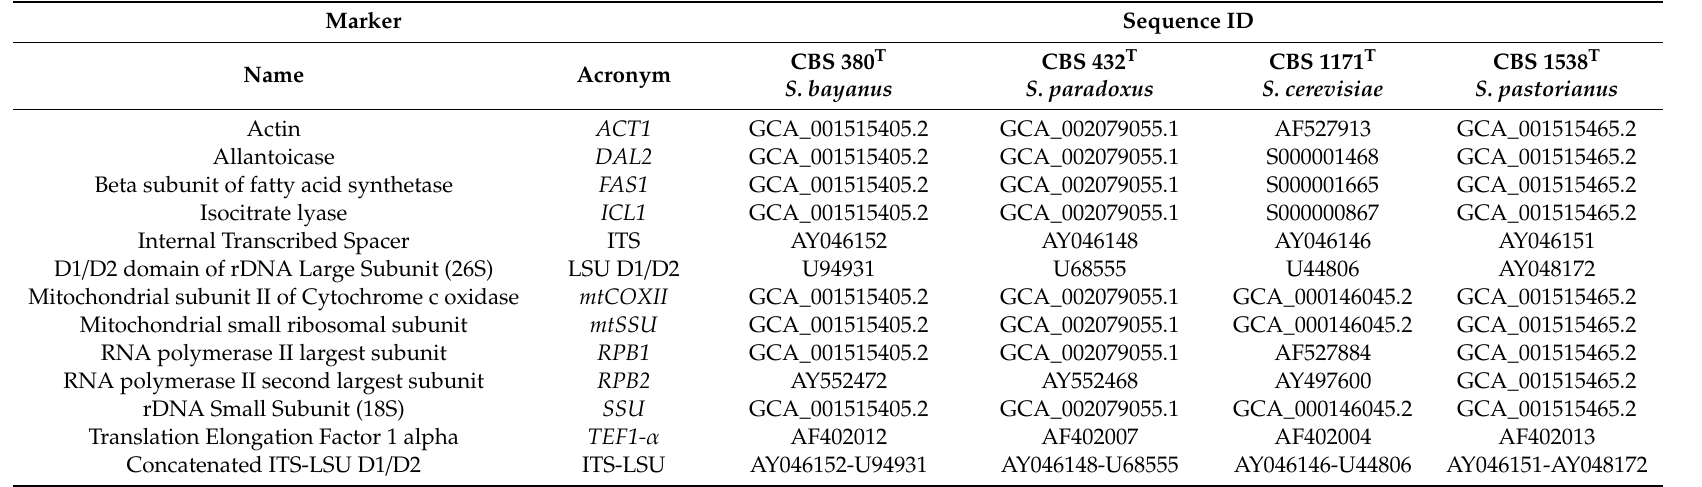
Table 1. Sequence IDs for the thirteen DNA markers used in the